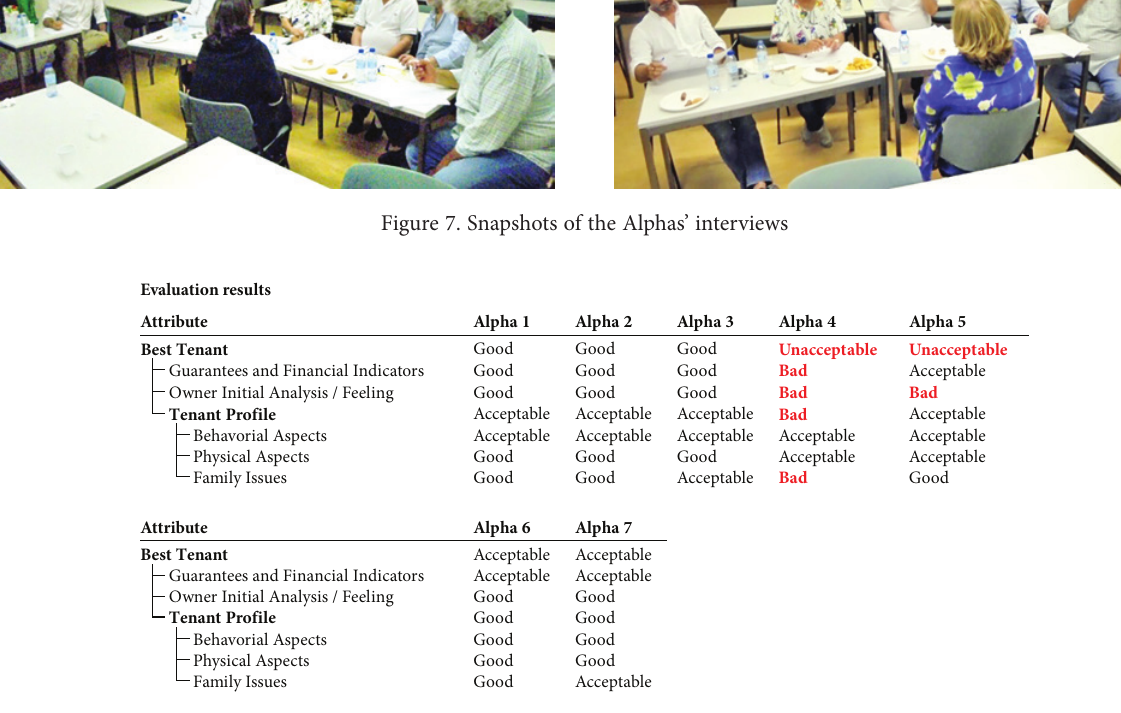
Figure 8. Evaluations of the Alphas [overall and per attribute]